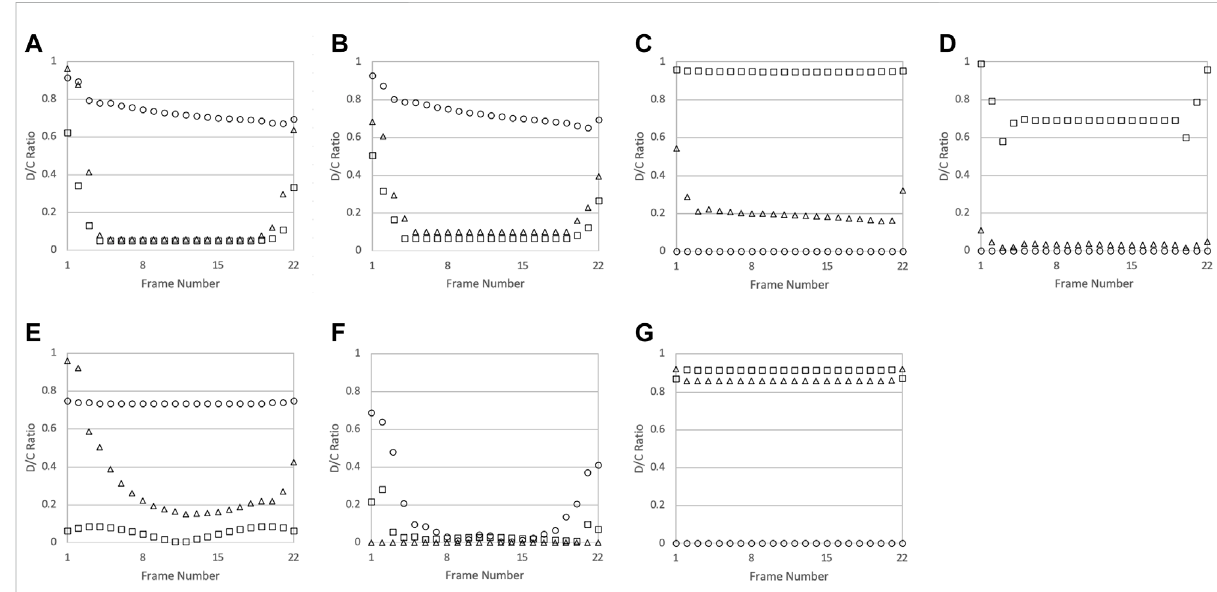
FIGURE 8 The D/C ratios of the connections throughout the roof structure: (A) Rafter RTWC; (B) Ceiling Joist RTWC; (C) Ceiling Joist to Rafter; (D) Collar TietoRafter; (E) RaftertoRidgeBoard; (F) CollarTieBracetoCollarTie;and (G) StruttoRafter&CeilingJoist.EachconnectionhasD/Cratiosshown for the axial direction ○ , and each shear direction △ , □ . Frame numbers 1 and 22 indicate the gable end